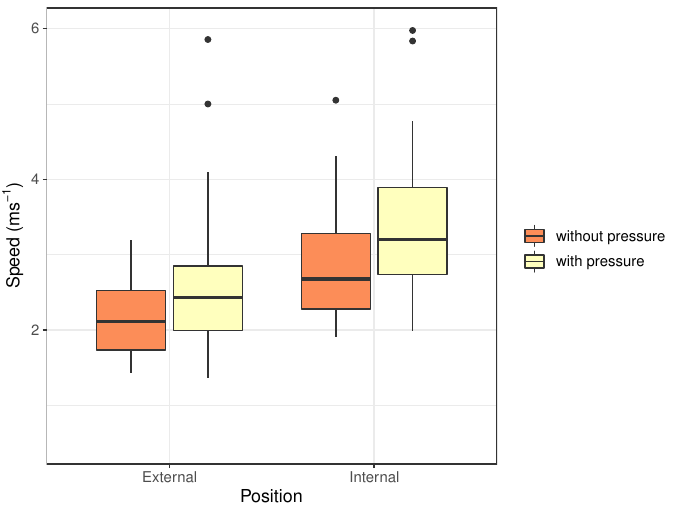
Figure 13. Distribution of measured shear-wave speed values at the internal and external positions with and without